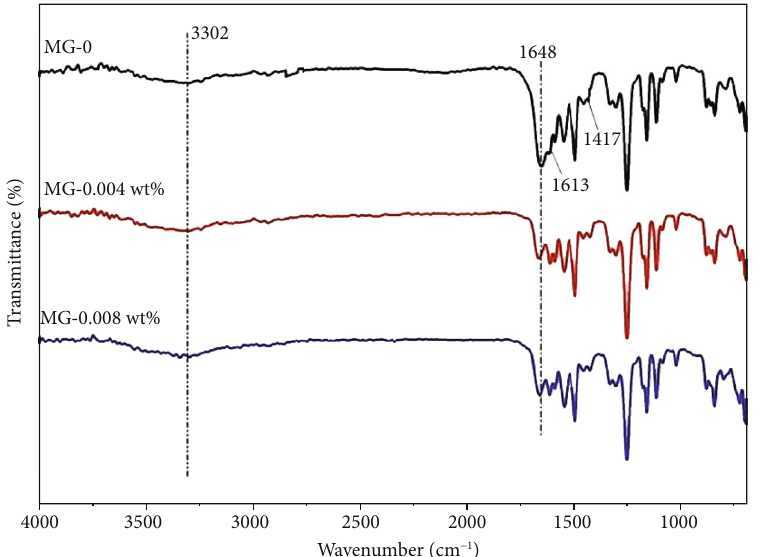
Figure 1: FT-IR spectra of composite membranes prepared with di ff erent MG concentrations.